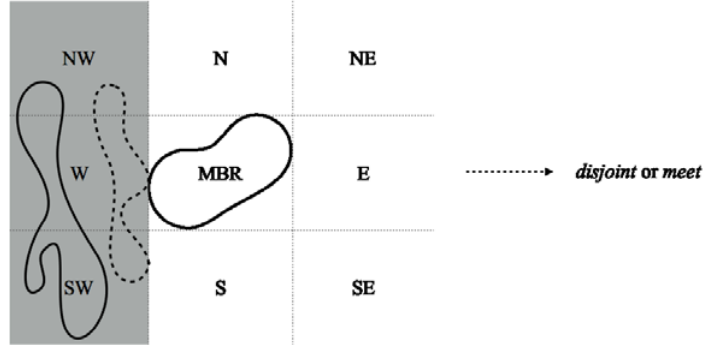
Figure 1: An example of converting a direction relation matrix symbol to a qualitative topo- logical relation. In this case, the direction relation matrix symbol (NW,W,SW) is demon- strated to result in disjoint (the solid outline) or meet (the dashed outline), an uncertain